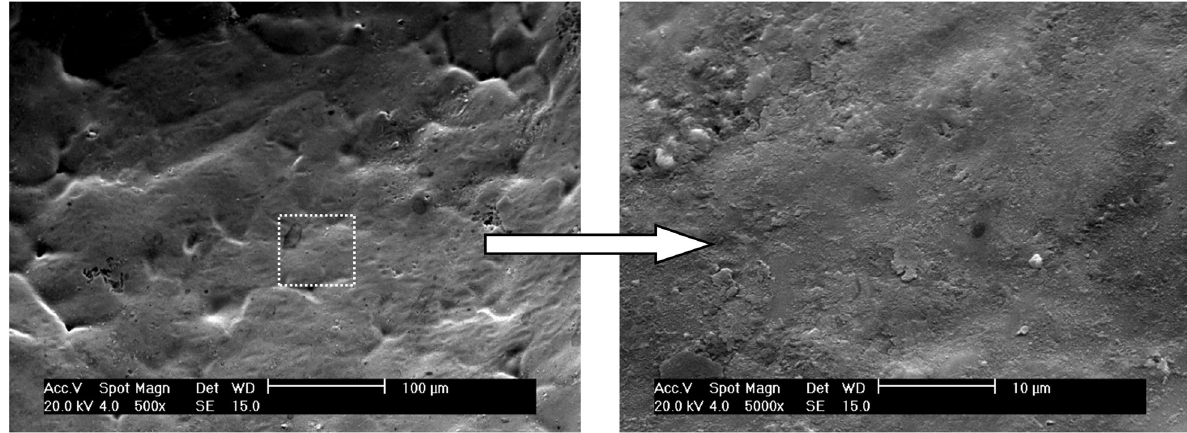
Figure 9. SEM micrographs showing cell wall surfaces of an Al